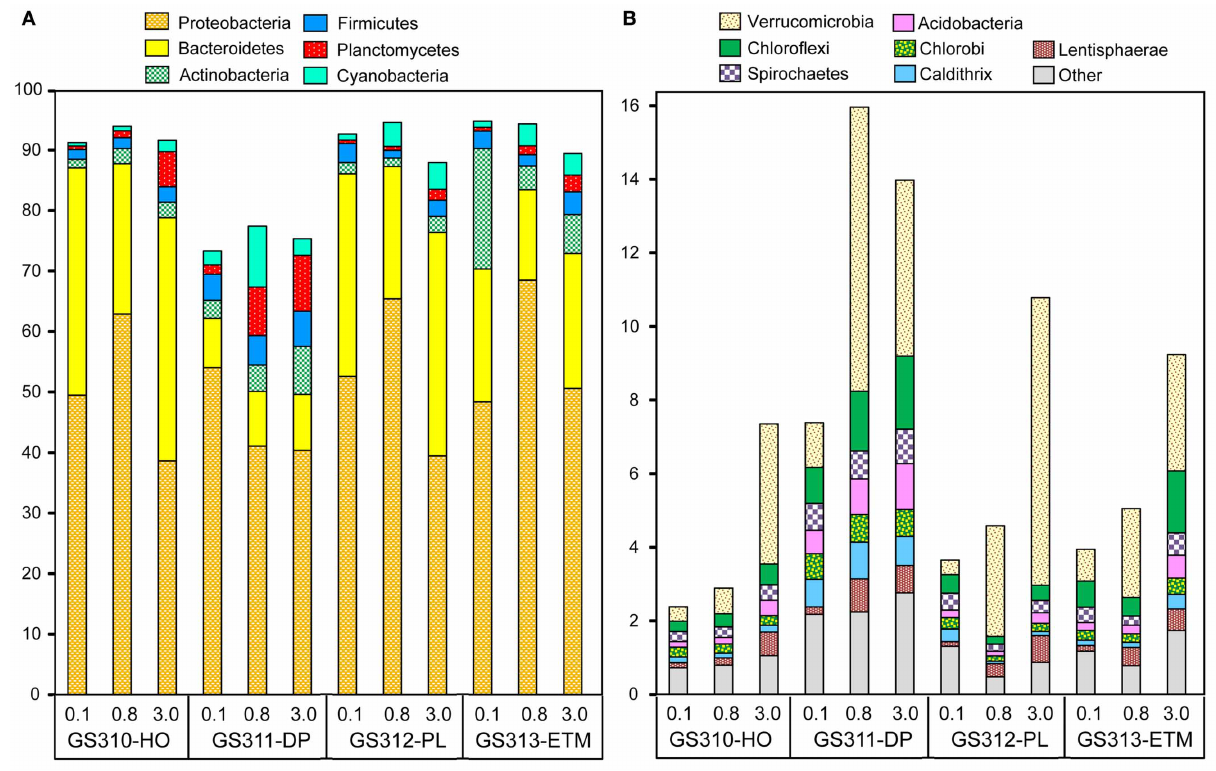
FIGURE 5 | Taxonomic composition of the domain Bacteria sequences in metagenomes. The abundance of a phylum in a size fraction was calculated as the percentage of all corresponding hits (with ≥ 30% sequence identity over > 70% of the alignment length) to the total annotated prokaryotic